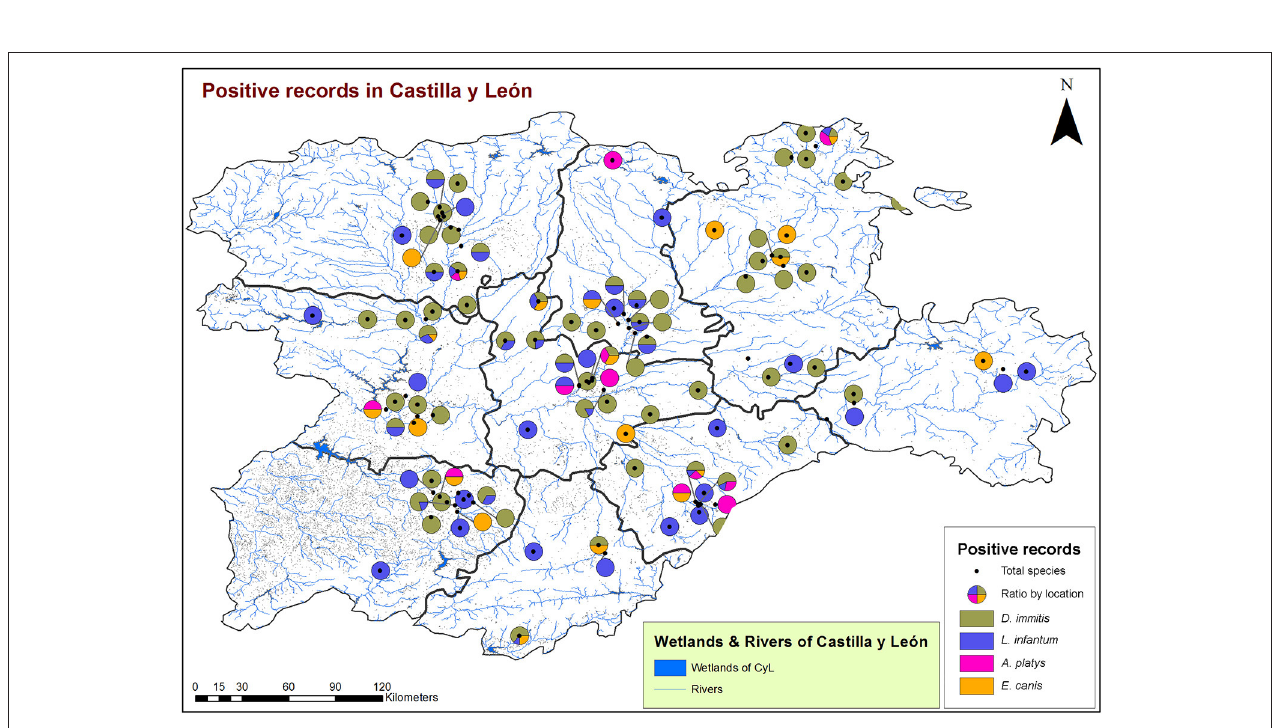
FIGURE 3 | Location of wetlands and rivers and geolocation of dogs infected by D. immitis ( ), and seroprevalences for L. infantum ( ), A. platys ( ), and E. canis ( ) in the nine provinces of Castilla y León, Spain.